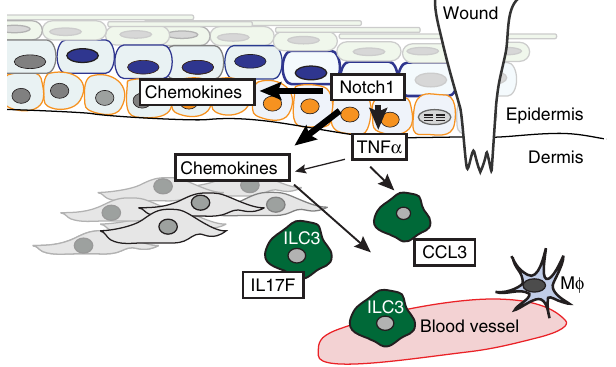
Figure 8 | Notch1 orchestrates wound healing through control of type 3 innate lymphoid cells (ILC3s). Skin wounding activates Notch pathway (orange cells) in the basal and suprabasal epidermis. Epidermal Notch1 regulates chemokine production in epidermal and dermal cells; injury- induced Notch1 activity upregulates TNF a , which can induce CCL20 in epidermal and dermal cells (grey cells). TNF a downstream of Notch1 regulates ILC3 localization within the dermis surrounding the wound and ILC3s are key sources of IL17F and early CCL3 production in the wound- healing cascade. ILC3s subsequently influence epidermal proliferation and macrophage (M f ) recruitment, two key events in the skin wound-healing